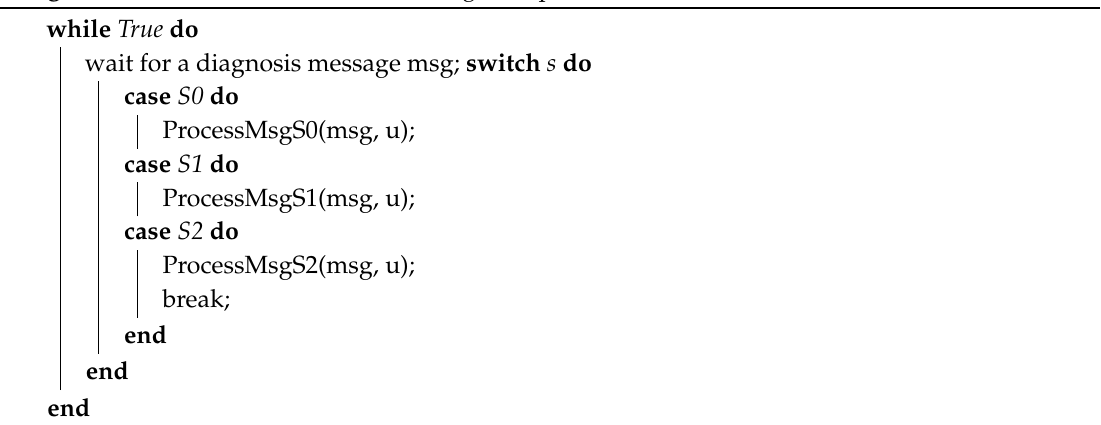
Algorithm 1: Demonstration of fault diagnosis protocol 1